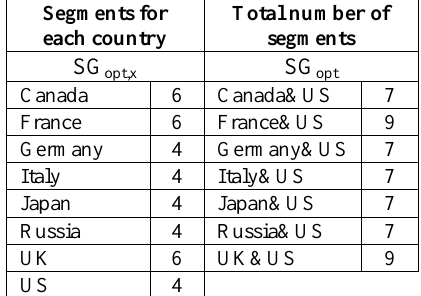
Table 1. Optimal number of